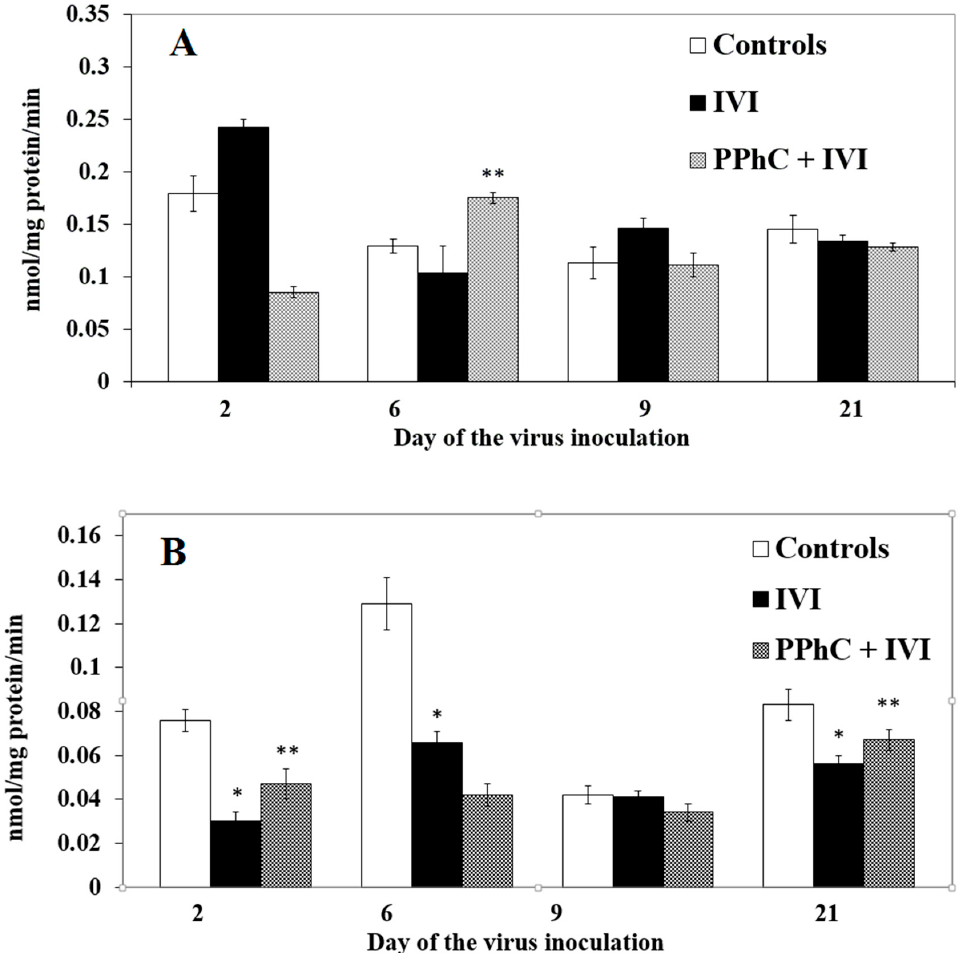
Figure 5. Panel of the liver enzyme of hydroxylase (with substrates p NF ( A ) and aniline-AN ( B ) activities characterizing the effect of PPhC in IVI-infected mice. Statistical significance ( p < 0.05) between the mean healthy group’s enzymatic activities vs. IVI models is indicated via the asterisk (*), and between the mean IVI group’s enzymatic activities vs. those treated with PPhC IVI models is indicated with a double asterisk (**).